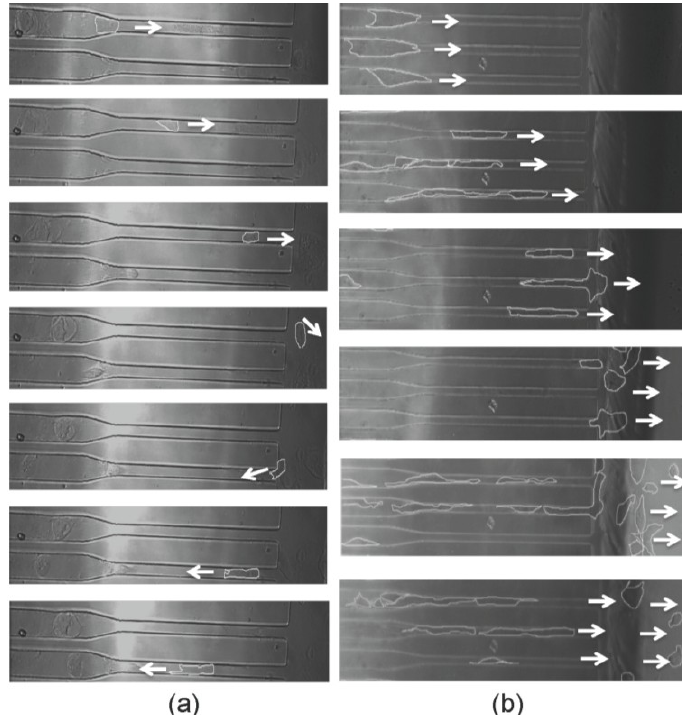
Figure 2. Time lapse microscopic images of migration behaviors for ( a ) PC-3 cells and ( b ) PNT1A cells, when seeded in the chamber at the wider (20 µm) end of the channel with an attractant (epidermal growth factor (EGF) at 75 ng/mL) added in the chamber near the narrow end (5 µm). The images were zoomed in to the tapered channel area. In the case of PC-3, the cells re-entered the channels, as indicated by the arrows. In the case of PNT1A, the cells migrated completely across the channels into the